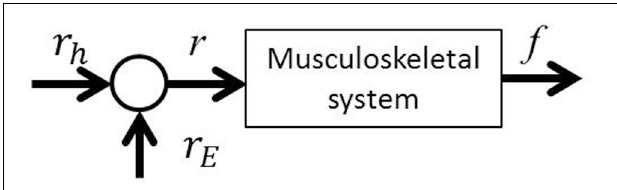
FIGURE 4 | EAA ratio-based FES control scheme.